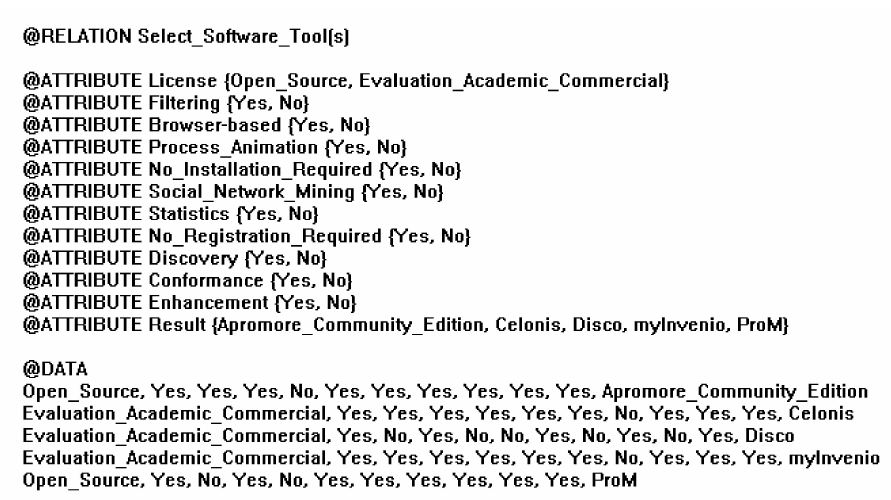
Figure 5. ( a ) Description of ProM class (Prot é g é 5.5.0); ( b ) DL Query (Prot é g é 5.5.0).